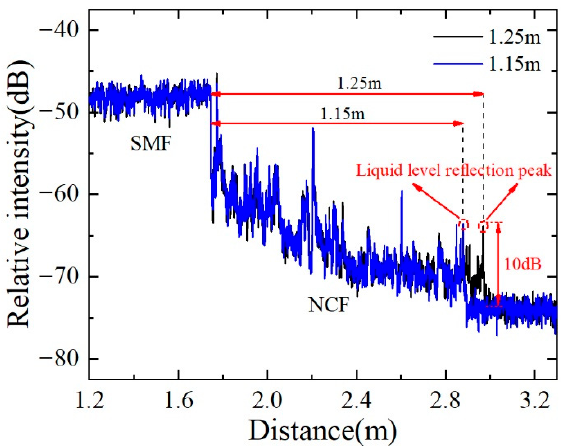
Figure 9. Reflection intensity of the liquid-level sensor with a sensing length of 1.25 m.